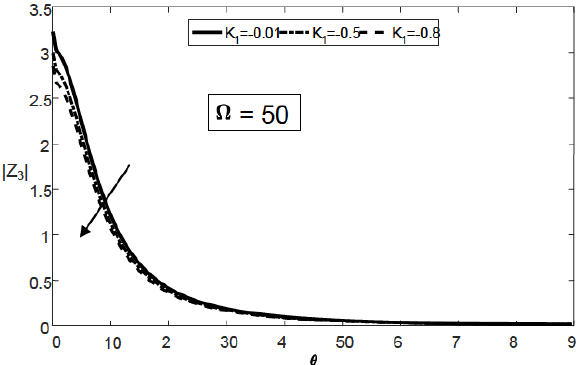
Figure 8: Amplitude ratio of third wave against incident angle for different variable thermal